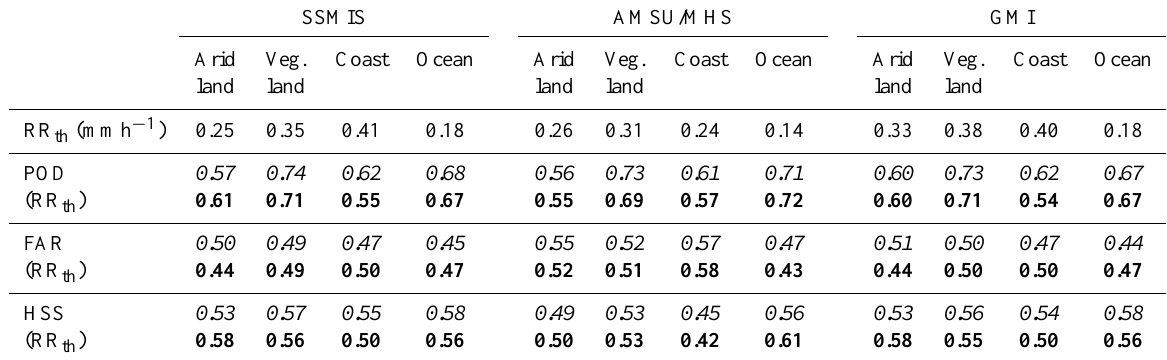
Table 3. Value of the mean rain rate corresponding to the CCA threshold set for every radiometer and surface background combination. Values in bold refer to the test data set while the italics values refer to the training data